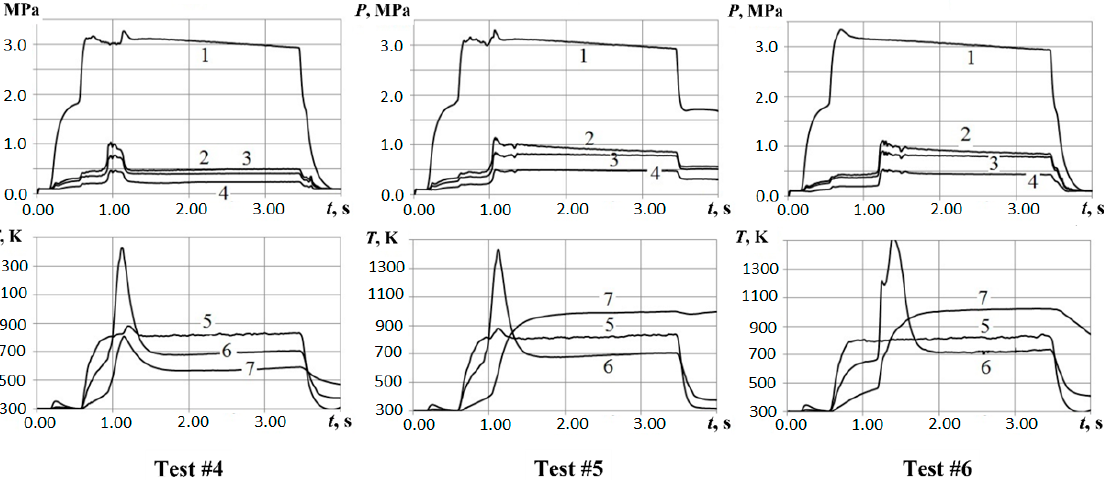
Figure 5. Test results at M 1 = 2.94 (see Table 1): 1— Р 0 ; 2— P 0,in ; 3— P 0,out ; 4— P out ; 5— T 0 ; 6— T 0,in ; 7— T 0,out.